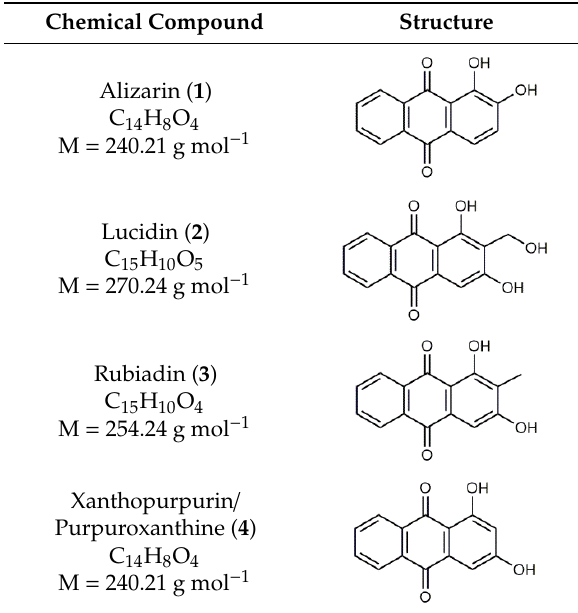
Table 1. Chemical structures of some natural anthraquinones.